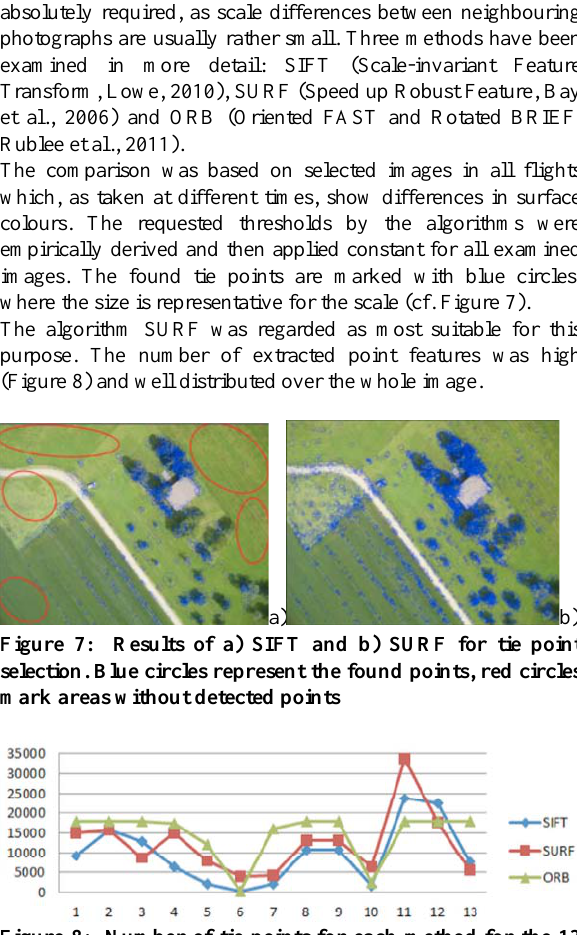
Figure 8: Number of tie points for each method for the 13 evaluated images.